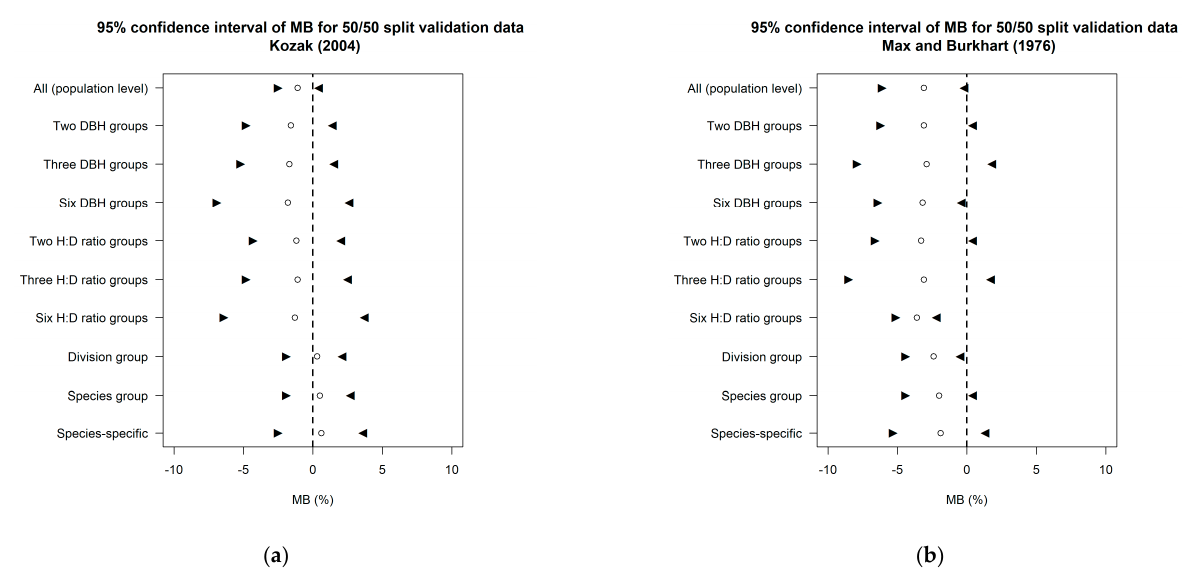
Figure 4. The estimate (circle dot) and 95% confidence interval boundaries (black triangles) of percent mean bias (MB) among data grouping strategies by Kozak (2004) and Max and Burkhart (1976) models. Fitting/validation datasets were split as 50/50 (%). ( a ) Kozak (2004), ( b ) Max and Burkhart (1976).